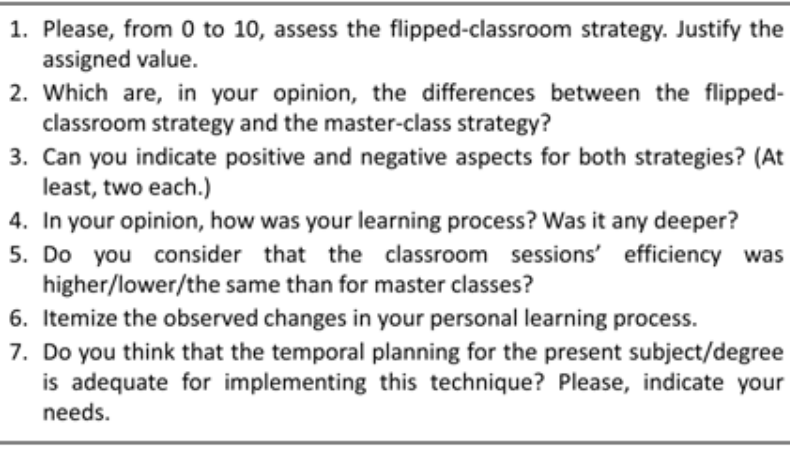
Figure 4. Satisfaction